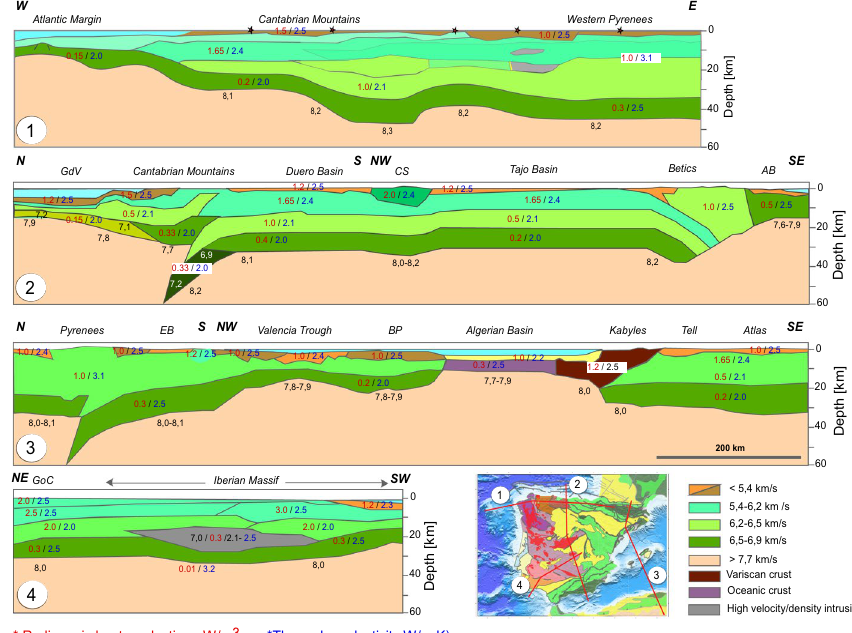
Fig. 5 Crustal profiles showing the distribution of V p , thermal conductivity and radiogenic heat production in the crust and uppermost lithospheric mantle. The map in the lower right corner shows the location of the profiles. Díaz and Gallart (2009) Adapted from, Pedreira et al. (2007), Carballo et al. (2015a, b) and Palomeras et al.